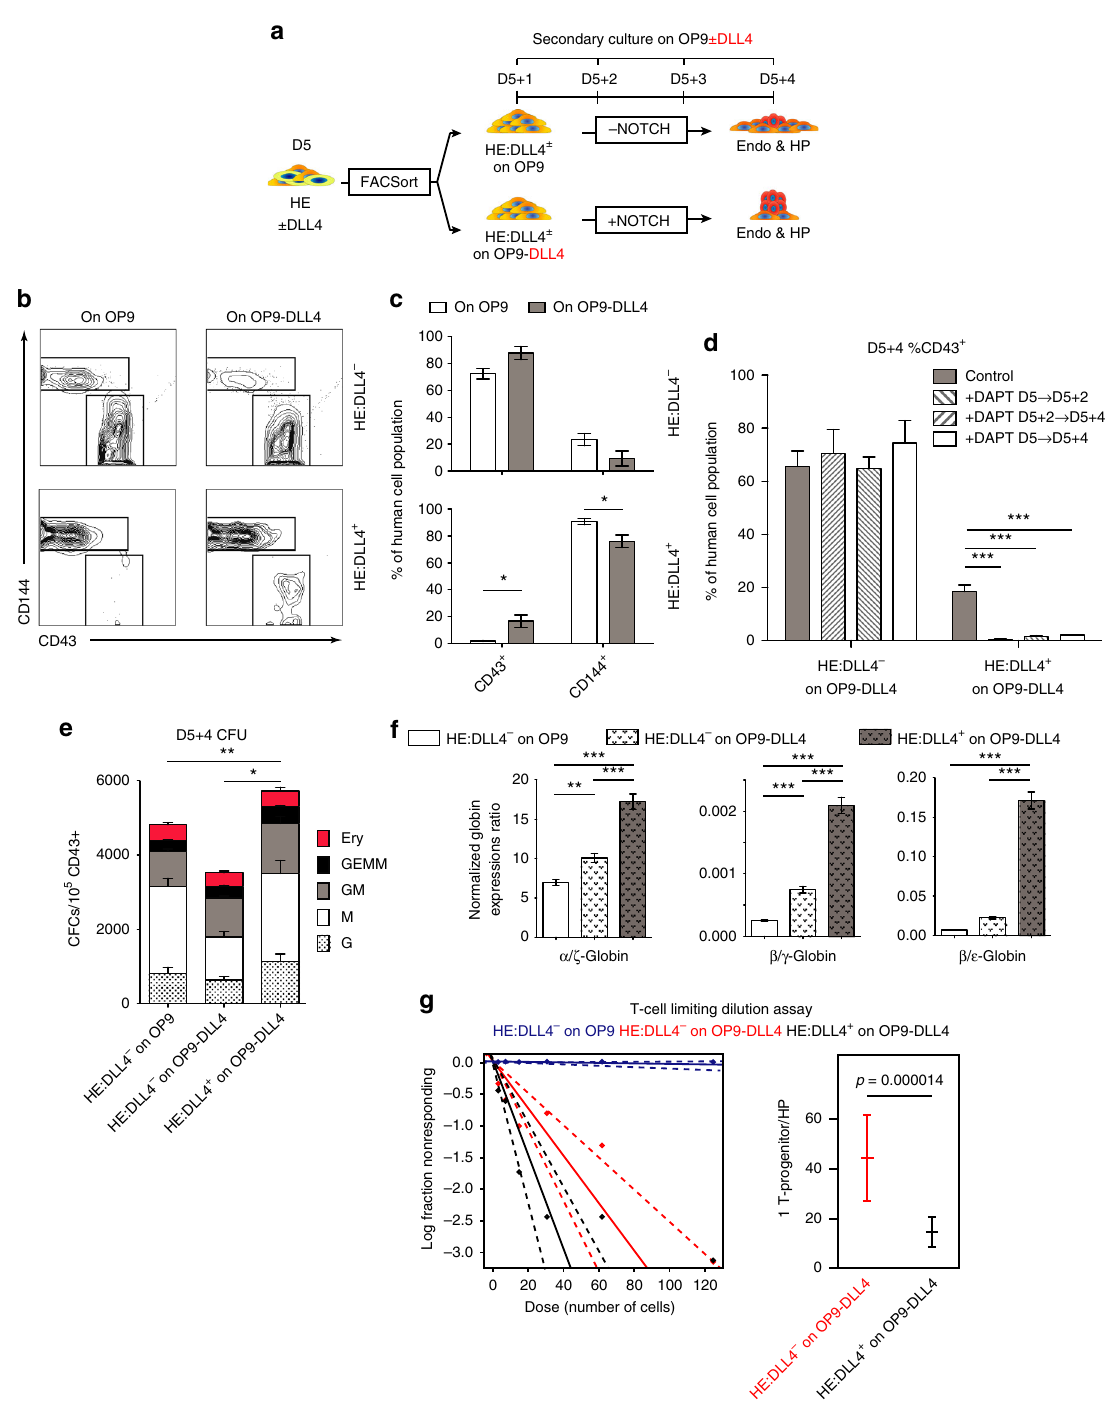
Fig. 5 Arterial-type HE undergoes EHT under high NOTCH activation and produce de fi nitive-type HPs. a Schematic diagram of subsequent experiments. D5 CD144 + CD43 − CD73 − were sorted based on DLL4 expression (D5 HE:DLL4 + / − ) using FACS and cultured on either OP9 or OP9-DLL4 for 4 days (D5 + 4). b , c Flow cytometric analysis of CD43 + hematopoietic and CD144 + endothelial cells following culture of D5 HE:DLL4 + and D5 HE:DLL4 − on either OP9 or OP9-DLL4. Bars in c are mean ± s.e.m. for at least three independent experiments. Two-way ANOVA Bonferroni post-hoc test, * p < 0.05. d The effect of NOTCH inhibition with DAPT on blood production from D5 DLL4 + and DLL4 − HE. No signi fi cant differences were found when HE:DLL4 − cells were treated with DAPT. Results are mean ± s.e.m. for three independent experiments. Two-way ANOVA Bonferroni post-hoc test, *** p < 0.001. e CFC potential of hematopoietic cells generated from D5 DLL4 + and DLL4 − HE following 5 days culture on OP9-DLL4. Results are mean ± s.e.m. for at least three independent experiments; two-way ANOVA Bonferroni post-hoc test, * p < 0.05, ** p < 0.01. CFC-GEMMs are signi fi cantly increased in DLL4 + cultures on OP9-DLL4. f Ratio of α / ζ , β / γ , and β / ε globin chain expression in erythroid cultures generated form hematopoietic cells collected from D5 DLL4 + and DLL4 − HE cultured on OP9-DLL4 (D5 + 4 cells). Results are mean ± s.e.m. for three independent experiments. one-way ANOVA Bonferroni post-hoc test, ** p < 0.01, *** p < 0.001. g Limiting dilution assay to determine the frequency of T-cell progenitors within the D5 + 5 HPs generated from HE: DLL4 − on OP9, HE:DLL4 − on OP9-DLL4, and HE:DLL4 + on